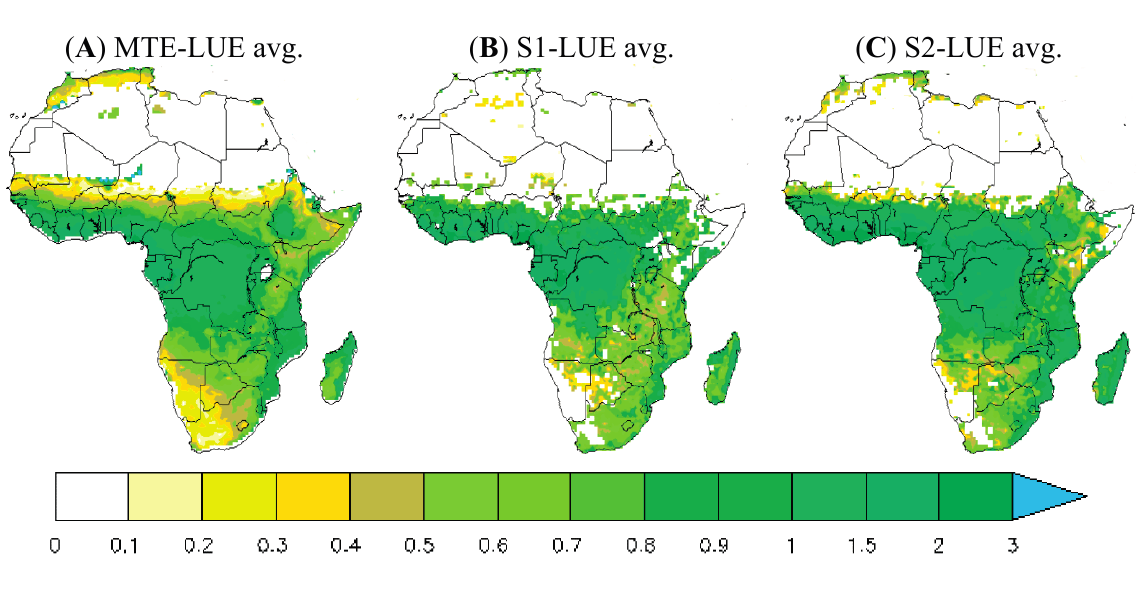
Figure 2. Same as Figure 1 for 1982–2010 LUE average ( gC · MJ (cid:2879)(cid:2869) · APAR